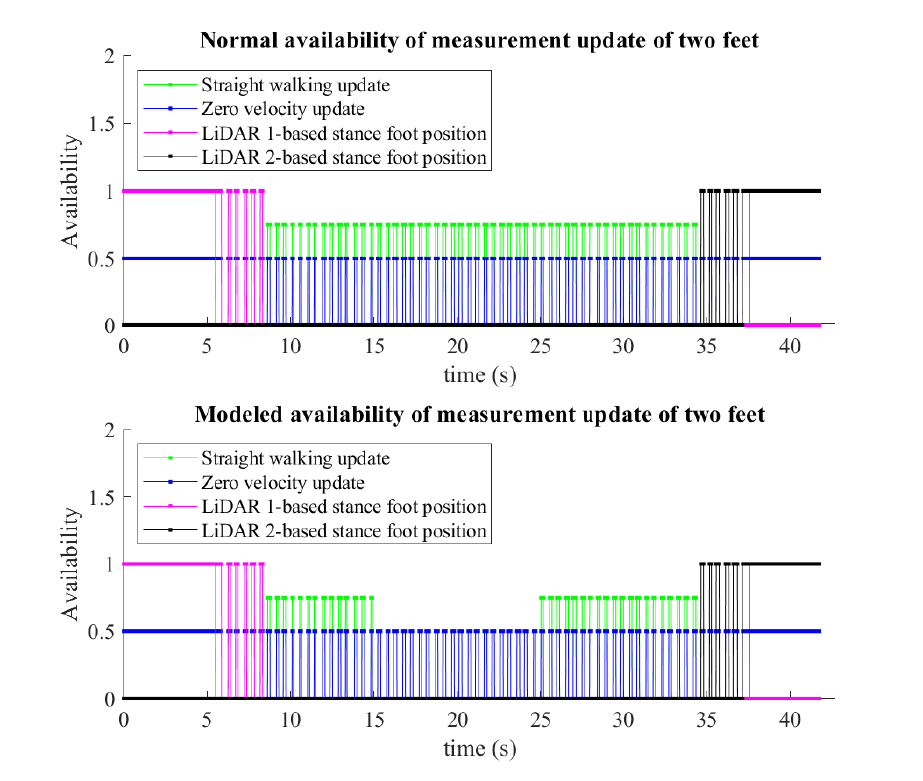
Figure 9. An example of measurement availability of two feet in 50 m walking. The straight-walking- based measurement updates are available for all walking steps outside the LiDAR range in the normal update ( top plot) and are removed by 10 s in the modeled update ( bottom